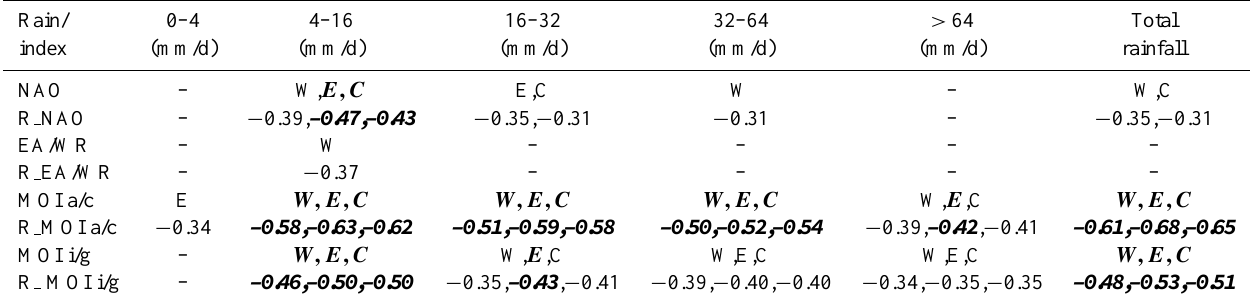
Table 1. Significant correlations (bold and italic: 99% level, plain text: 95% level) between the cold-season rainfall categories and the teleconnection indexes, for the two sub-regions of Calabria (W, E) and for the whole region (C). The value of the Spearman regression coefficient is also reported for each significant correlation (rows: R NAO, R EA/WR, R MOI a/c, R MOI